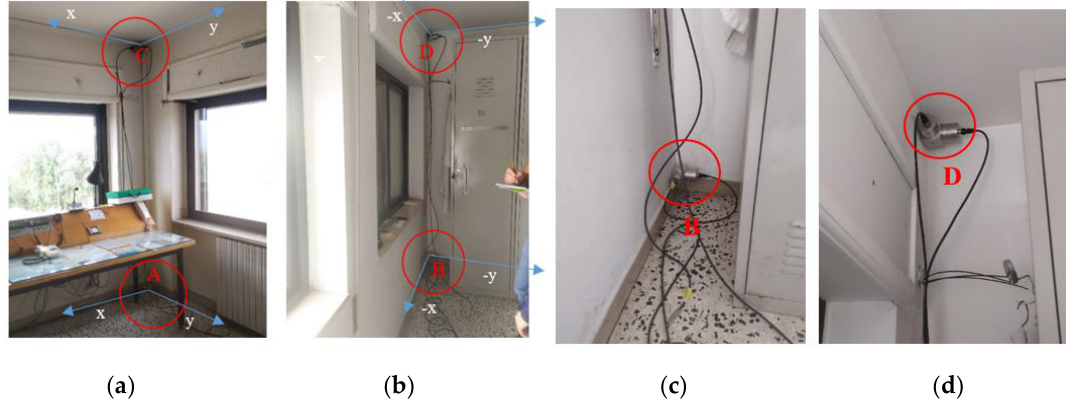
Figure 5. ( a ) Acquisition points A and C and the adopted reference system; ( b ) acquisition points B and D; ( c ) details of accelerometers positioned in point B by means of the cubic element; ( d ) details of accelerometers mounted on point C by means of the cubic element.